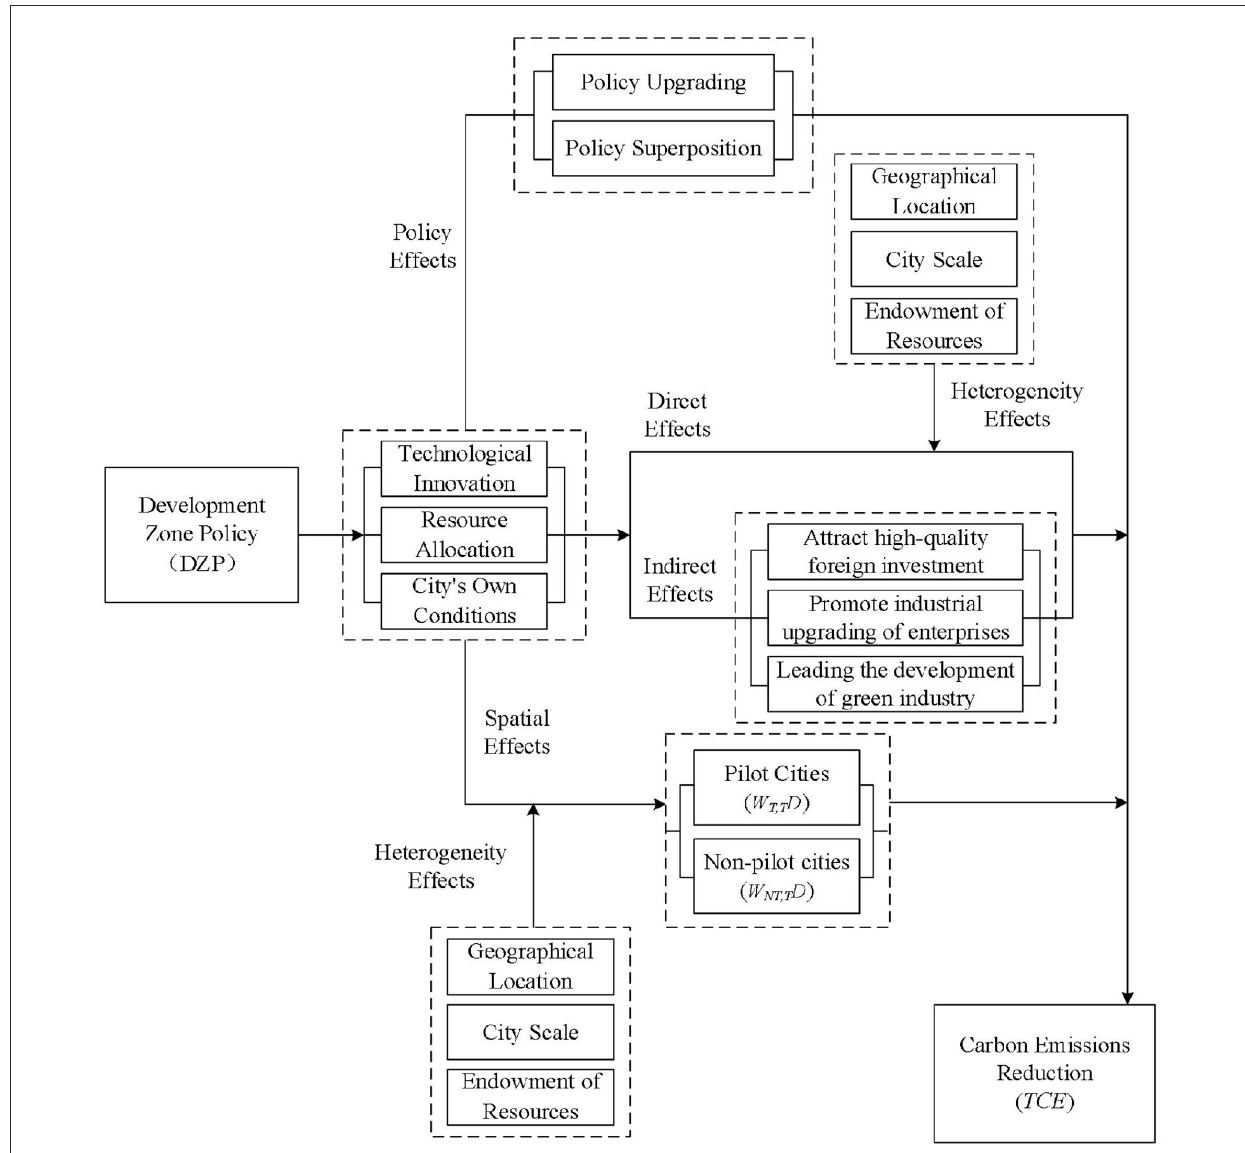
FIGURE1 Flowchart of theoretical